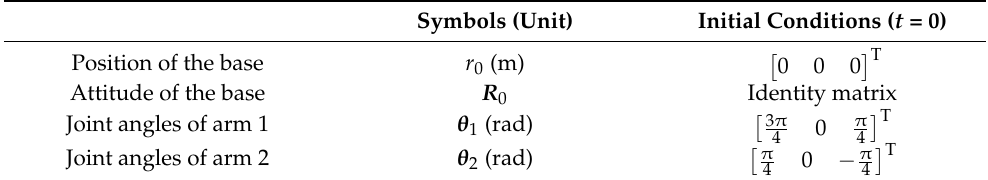
Table 2. Initial states of the robot system.